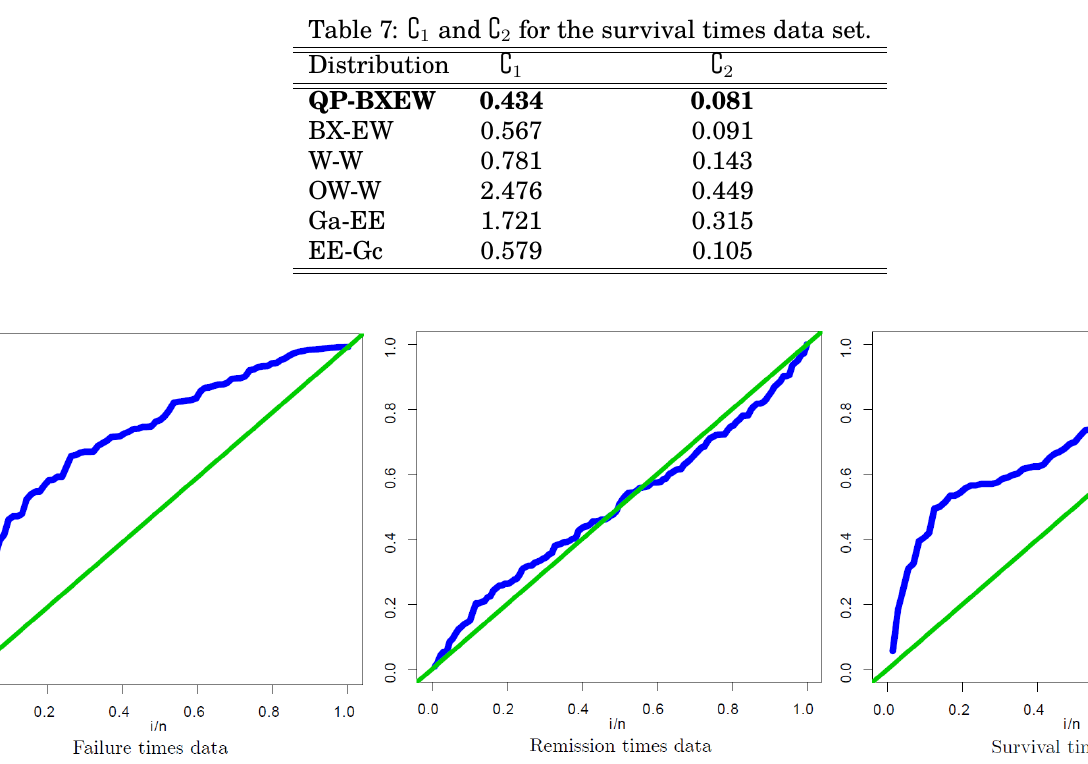
Figure 2: TTT plots.